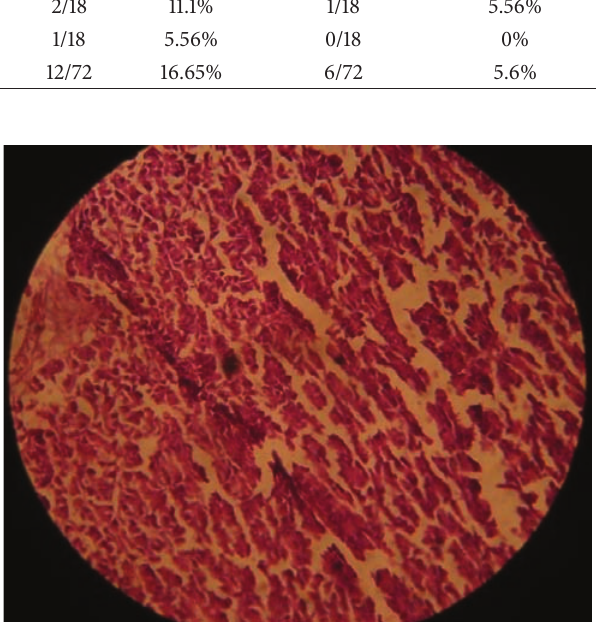
Figure 2: Pancreas of stunted chick showing fibrosis.